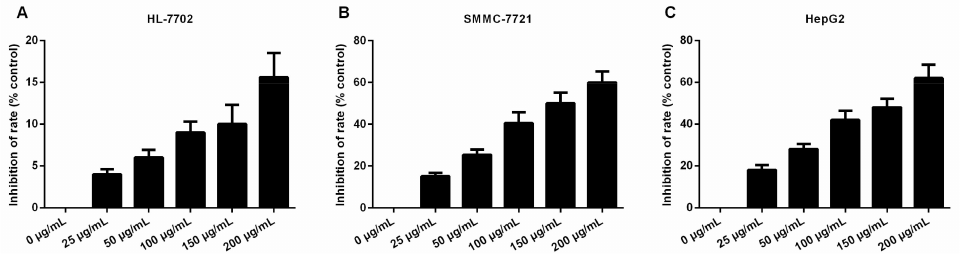
Figure 1. Daucosterol decreased the proliferative capacities of HL-7702, HepG2, and SMMC-7721 cells. CCK-8 assays were performed to determine the inhibition of HL-7702 ( A ); SMMC-7721 ( B ); and HepG2 ( C ) cell proliferation upon treatment with varying concentrations of daucosterol for 48 h.